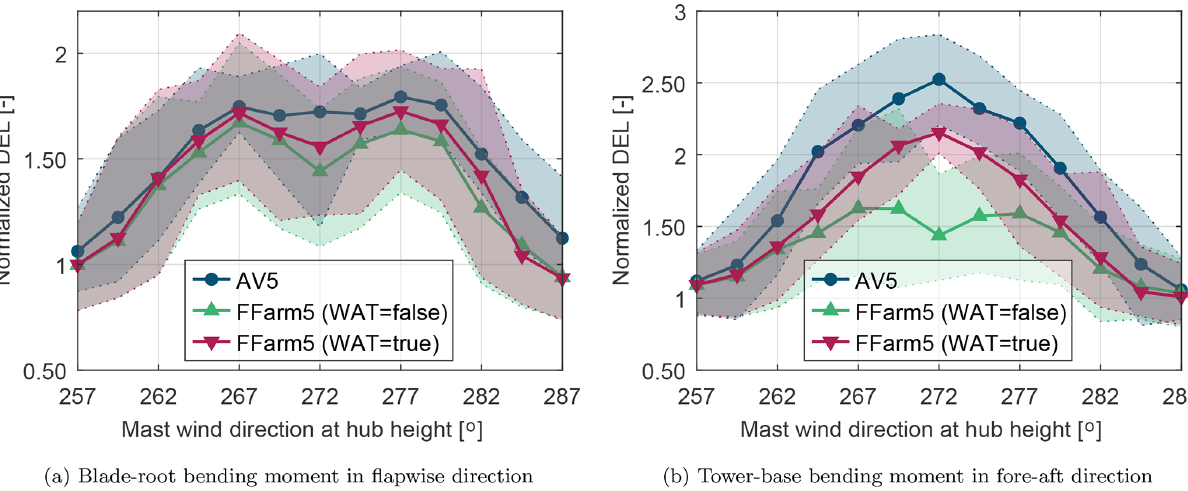
Wind Energ. Sci., 6, 1247–1262,